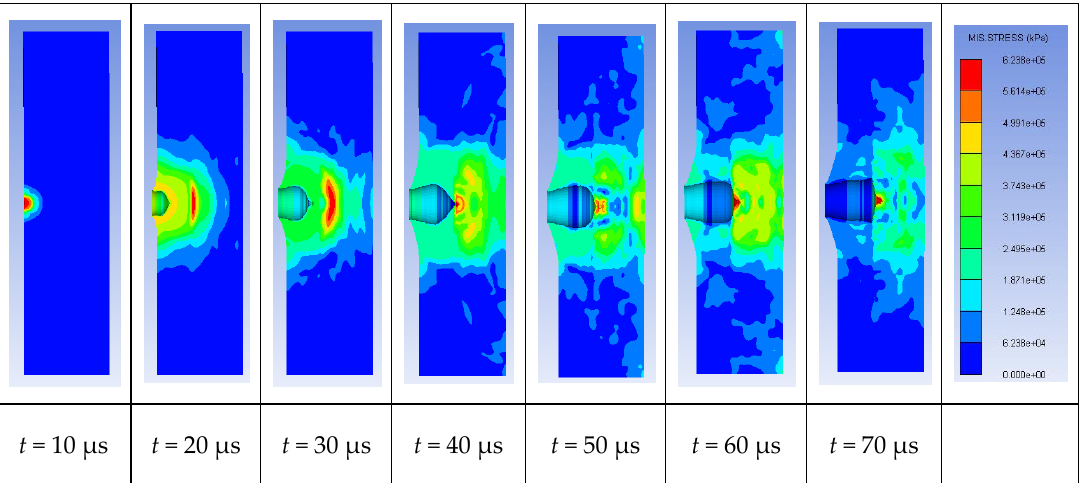
Figure 18. Stress distribution patterns of Configuration B panel at time between 10 μs and 70 μs at initial projectile velocity of 800 m/s.